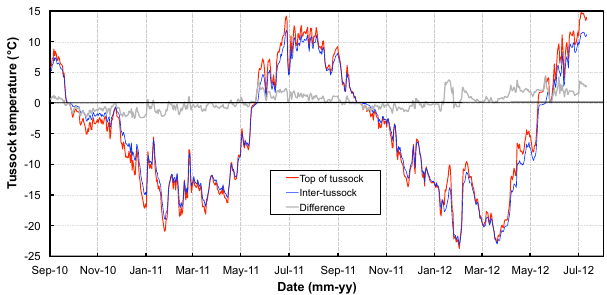
Figure 9. Temporal temperature variations for the top of tussock (red), the intertussock (blue), and the temperature difference (gray) between the two at the UT site from 28 August 2010 (DOY 240) to 11 July 2012 (DOY 923).